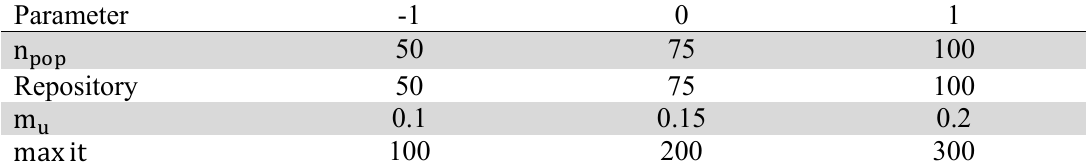
Coding parameters and levels tested for MOPSO Parameter -1 0 1 n (cid:2926)(cid:2925)(cid:2926) Repository